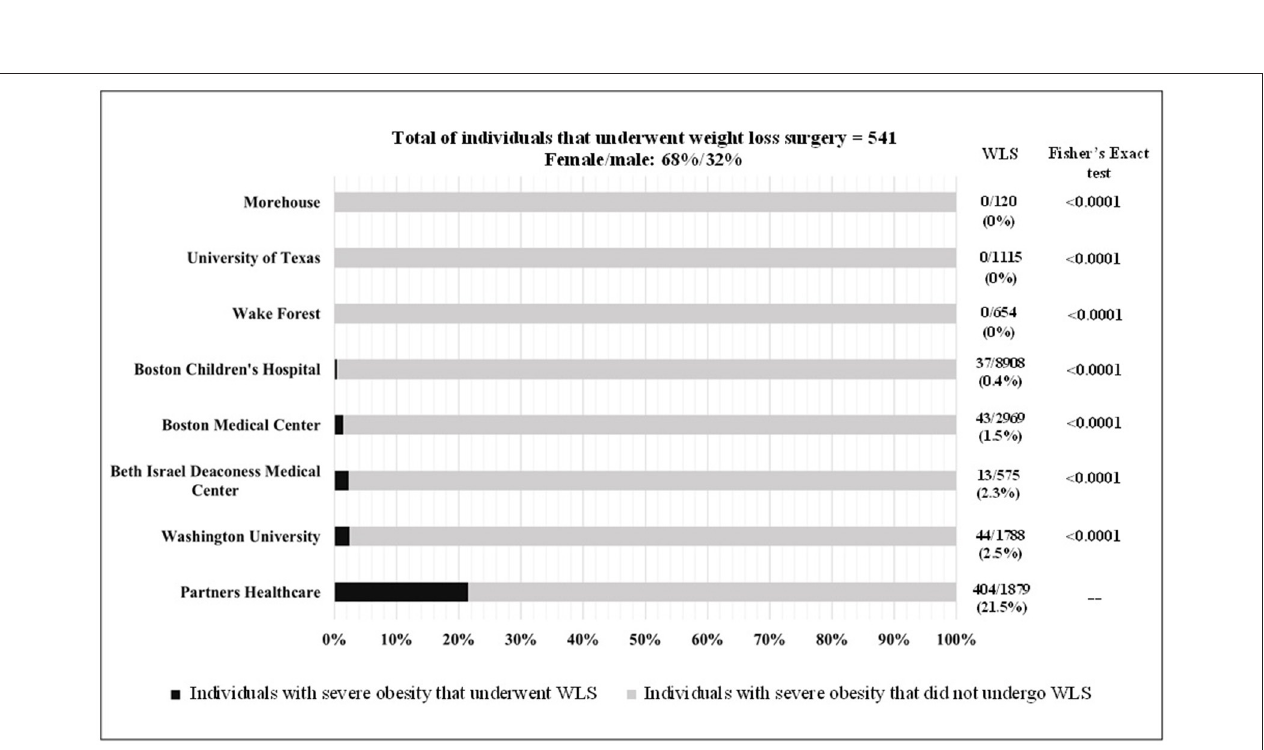
FIGURE 1 | Weight loss surgery utilization in patients 14-25 years old in several healthcare academic institutions in US.